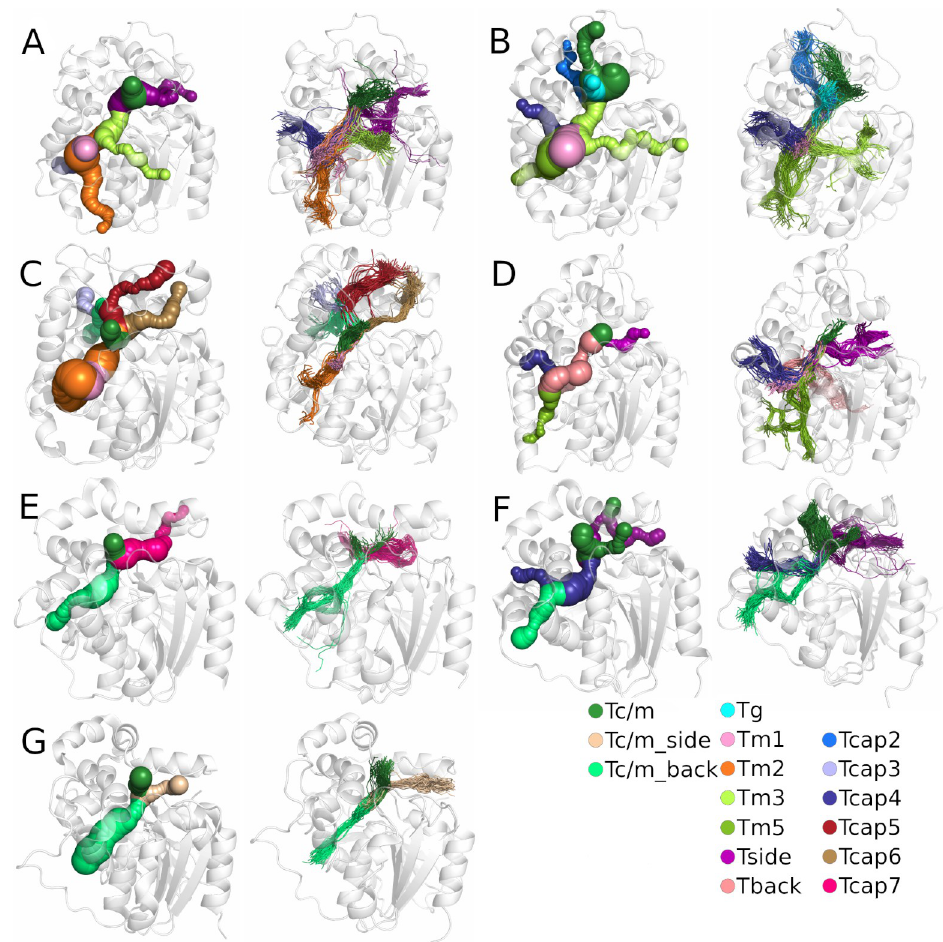
Fig 2. Comparison of tunnels identified in the crystal structure (left) and the results after molecular dynamics (MD) simulation (right) for each system: A) M . musculus soluble epoxide hydrolase (msEH), B) H . sapiens soluble epoxide hydrolase (hsEH), C) S . tuberosum soluble epoxide hydrolase (StEH1), D) T . reesei soluble epoxide hydrolase (TrEH), E) B . megaterium soluble epoxide hydrolase (bmEH), and thermophilic soluble epoxide hydrolases from an unknown source organism F) Sibe-EH, and G) CH65-EH. Protein structures are shown as white transparent cartoons. Matching tunnels are marked with the same colour as spheres (in crystal structures) and lines (in MD